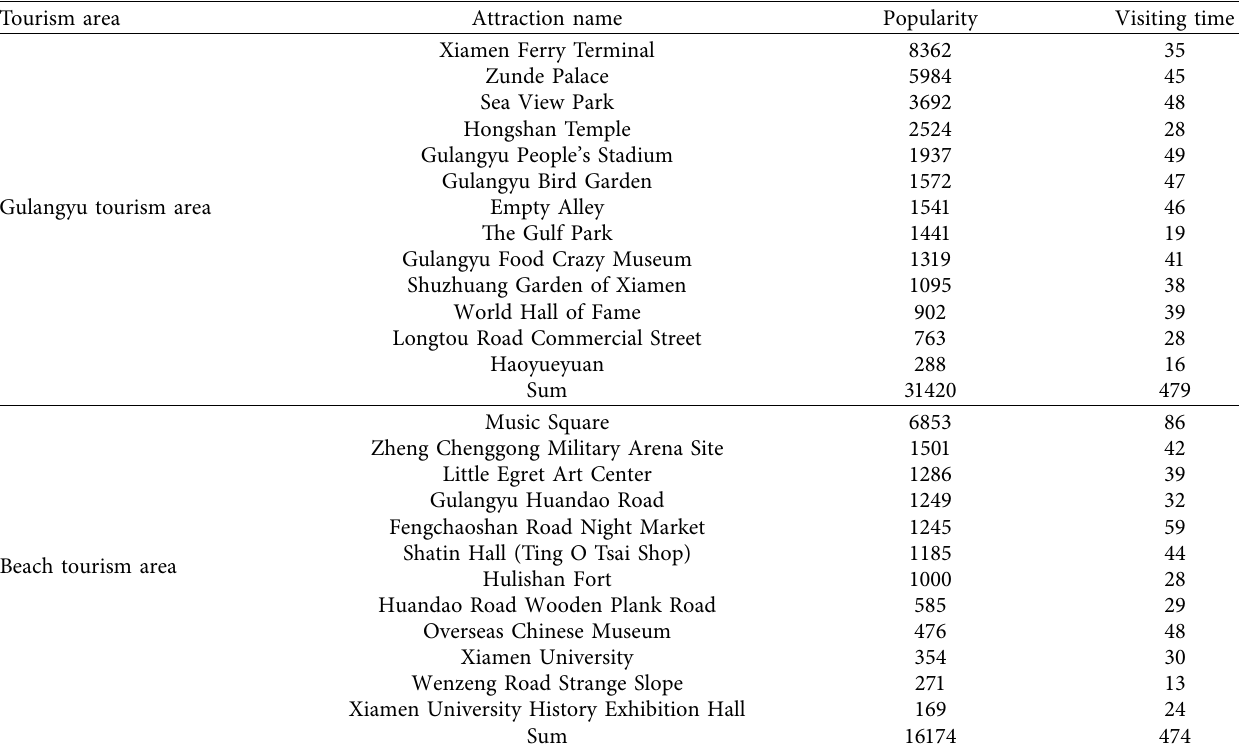
Table 1: The recommended visiting time and popularity for each attraction (visiting time: min).